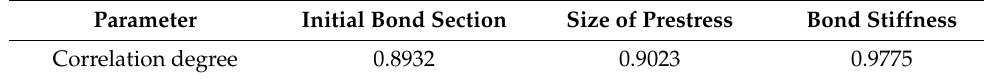
Table 4. The relevance data of each impact